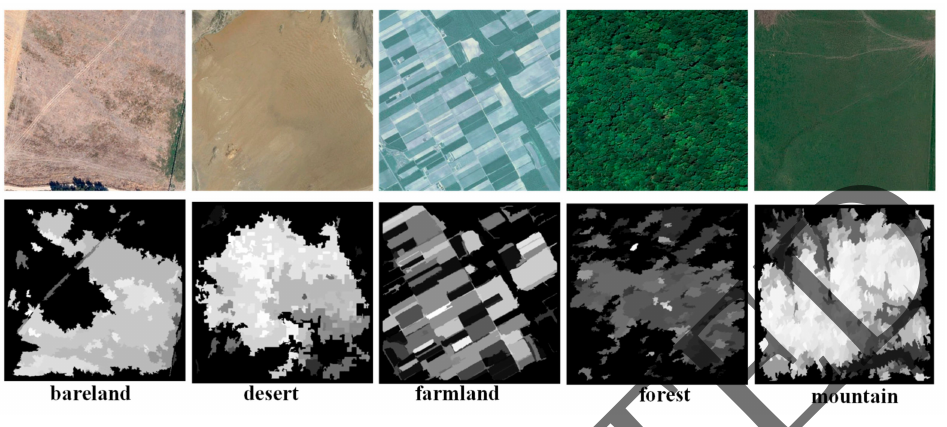
Figure 3. Attention maps of scenes of repeated